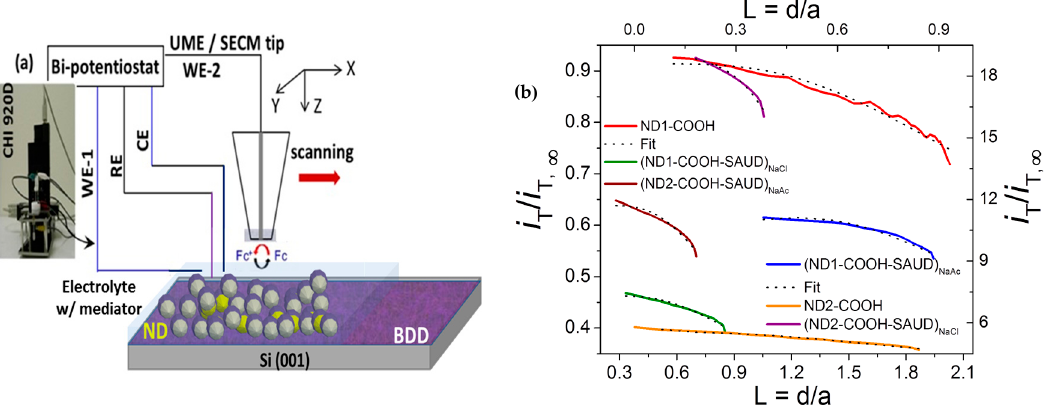
Figure 7. ( a ) scanning electrochemical microscopy (SECM) with (ultra) microelectrode (UME) tip as working (WE), counter (CE) and reference (RE) electrodes operating in feedback mode during oxidation of Redox (R/O) mediator species in base electrolyte at the tip positioned for ND immobilized BDD electrode substrate; ( b ) Probe approach curves for all the unprocessed and processed nanodiamond samples indicative of extent of semiconducting (or insulating) behavior at the solid/liquid interface in redox mediator 5 mM FcMeOH (ferrocene methanol) in support electrolyte 0.05 M K 2 SO 4 with tip voltage V t = +0.25 V and substrate voltage V s = − 0.4 V. The corresponding theoretical fitting is also plotted as dash curves.